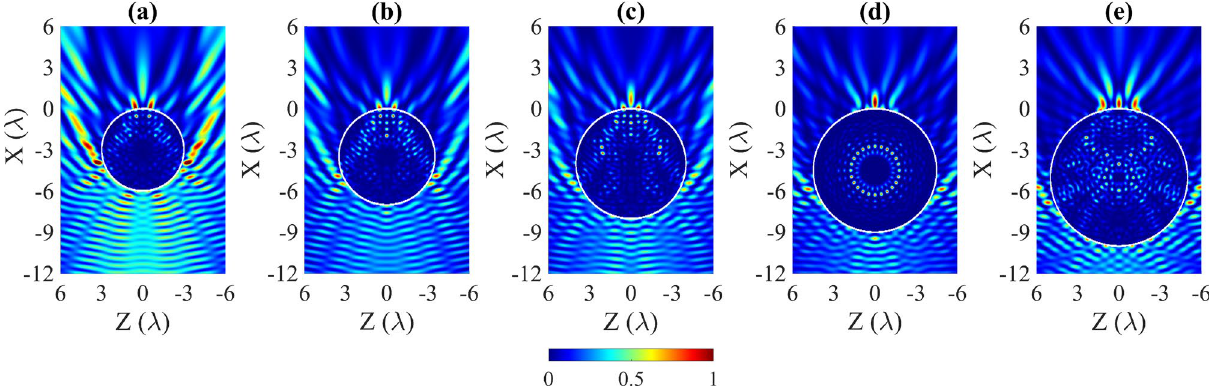
Figure 1. Normalized acoustic intensity planes ( I / I max ) for different ABS cylinder sizes of ( a ) 3 (cid:31) , ( b ) 3.5 (cid:31) , ( c ) 4 (cid:31) , ( d ) 4.5 (cid:31) and ( e ) 5 (cid:31) . Radius ( (cid:31)